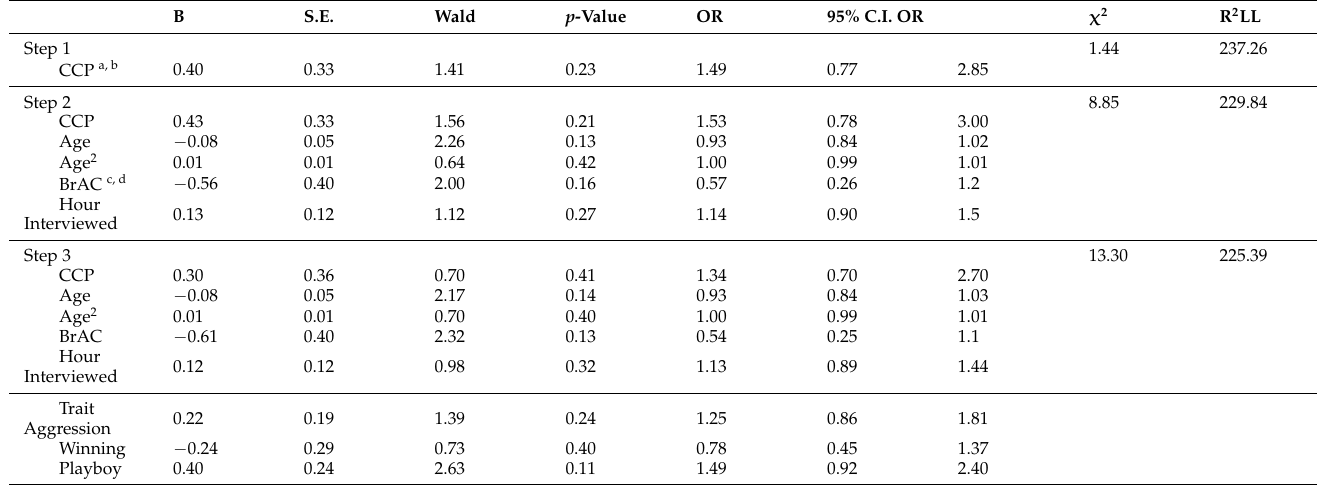
Table 2. Hierarchical Logistic Regression of UWSA for Female